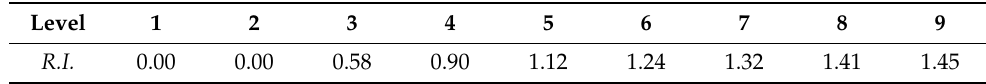
Table 4. Random index value for each level of